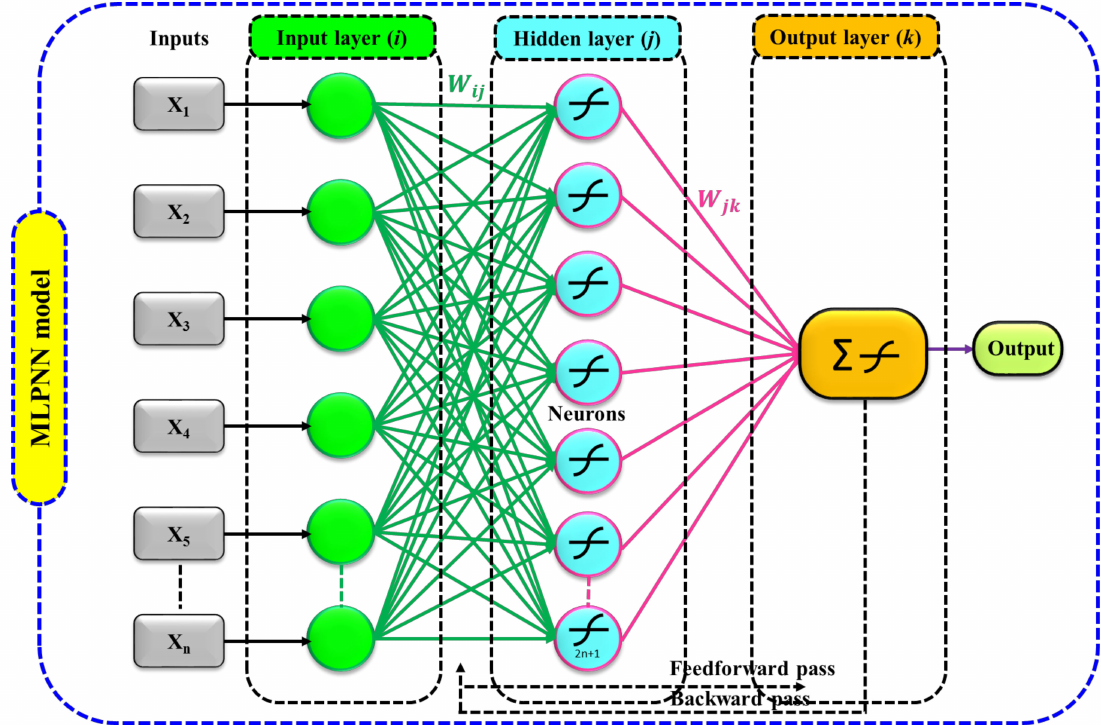
Figure 3. Three-layer multi-layer perceptron neural network (MLPNN) model